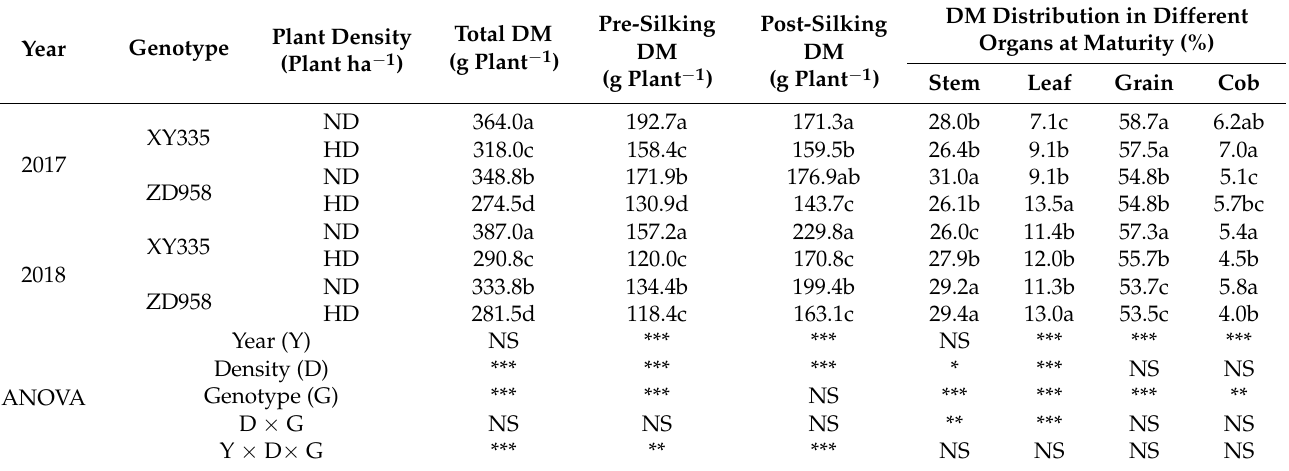
Table 2. Effect of plant density on dry matter and distribution in different organs of two maize hybrids in 2017 and